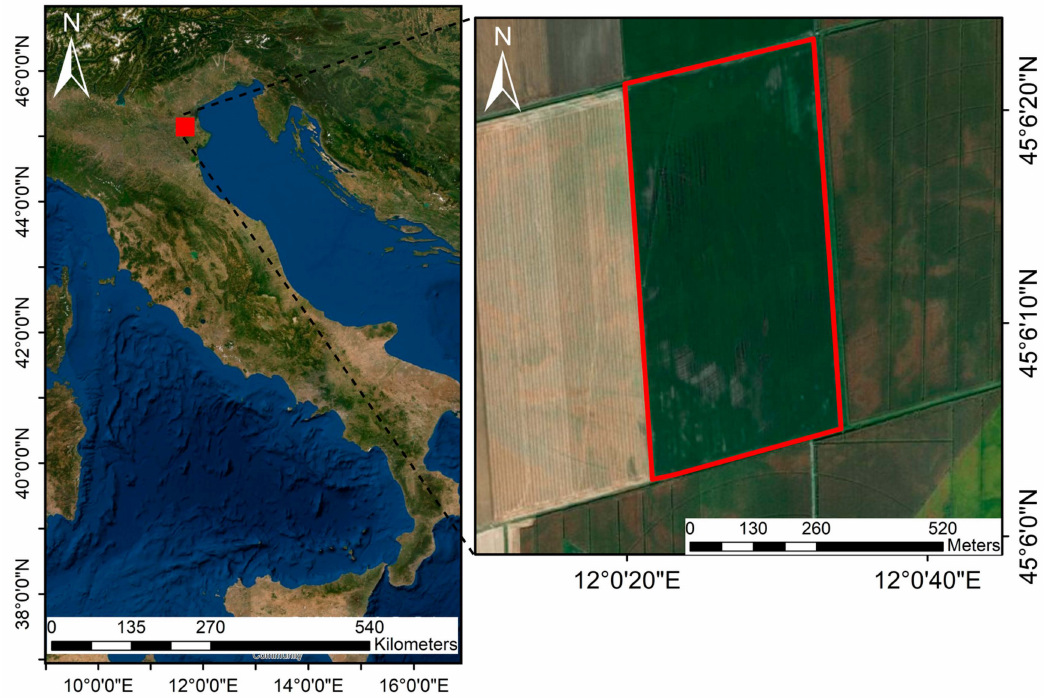
Figure 1. Aerial image of the study area with the field boundaries (in